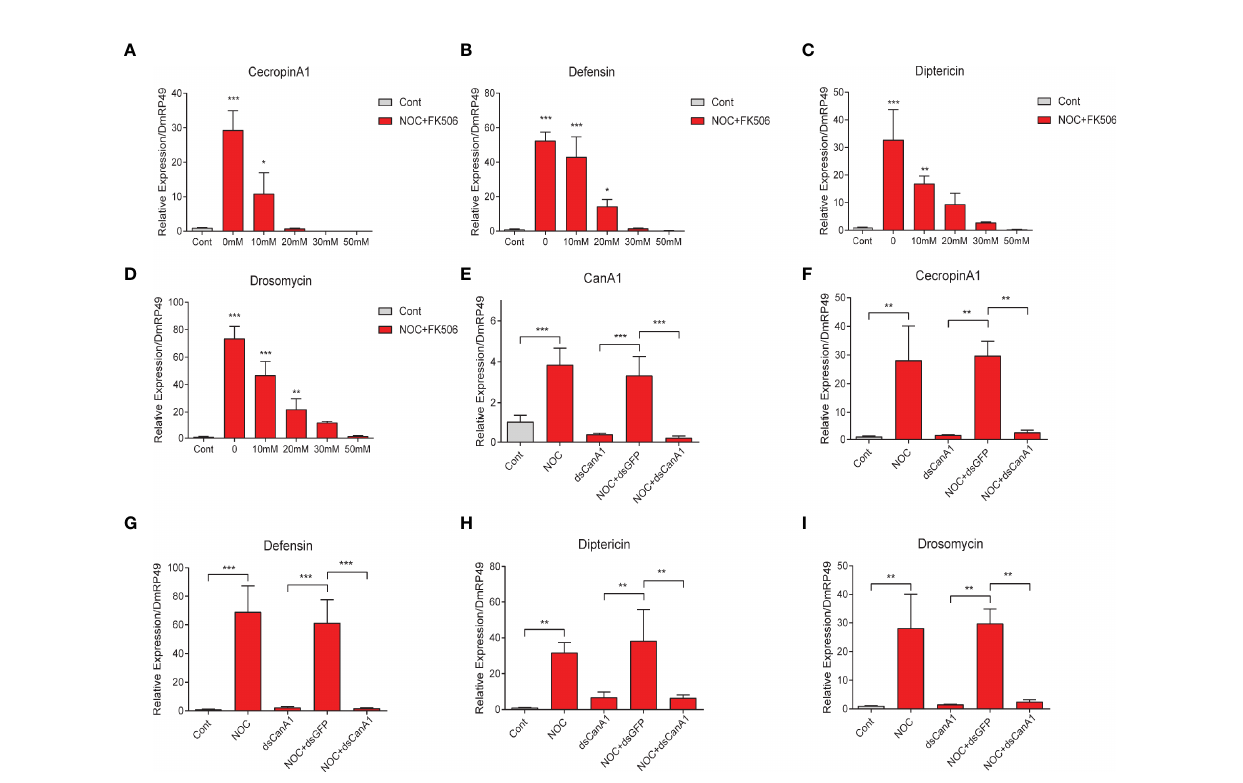
FIGURE 8 | Effects of CanA1 knockdown and CanA1 inhibitor on NOC-induced AMP expression. Transcript level changes of Cecropin A (A) , Defensin (B) , Diptericin (C) and Drosomycin (D) in NOC treated S2 cells after different concentrations of CanA1 inhibitor treatment were determined by qPCR, The concentrations of FK506 were indicated. dsRNA of CanA1 was used to evaluate the effects of NOC on the expression of CanA1 (E) , Cecropin A1 (F) , Defensin (G) , Diptericin (H) and Drosomycin (I) in response to NOC challenge. Cont, PBS used as control; NOC, nitric oxide donor; CanA1, CalcineurinA1. One-way ANOVA followed by Tukey ’ s test was used to compare control and treatment groups (A-D) . Student ’ s t-test was used to analyze signi fi cance (E-I) , * p < 0.05; ** p < 0.01; *** p <